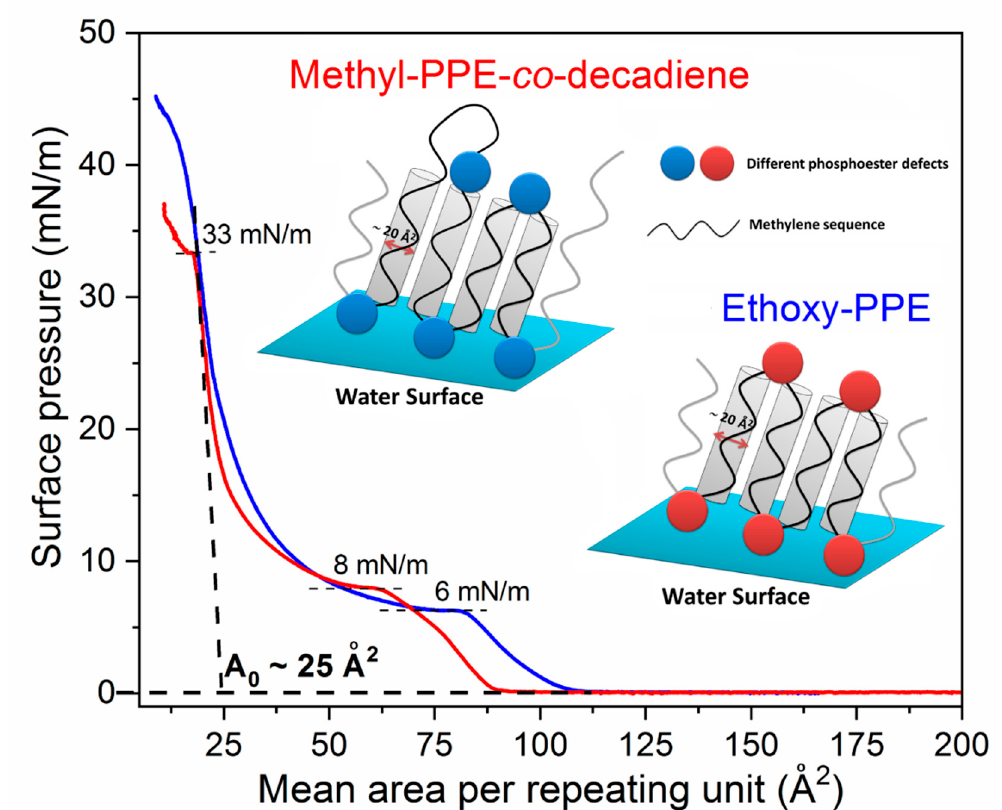
Figure 2. π - A isotherms of two different PEs measured at a subphase temperature of 20 °C with a compression rate of 50 Å 2 / (molecule min). The insets show the possible chain orientation of the PEs at A 0 position.